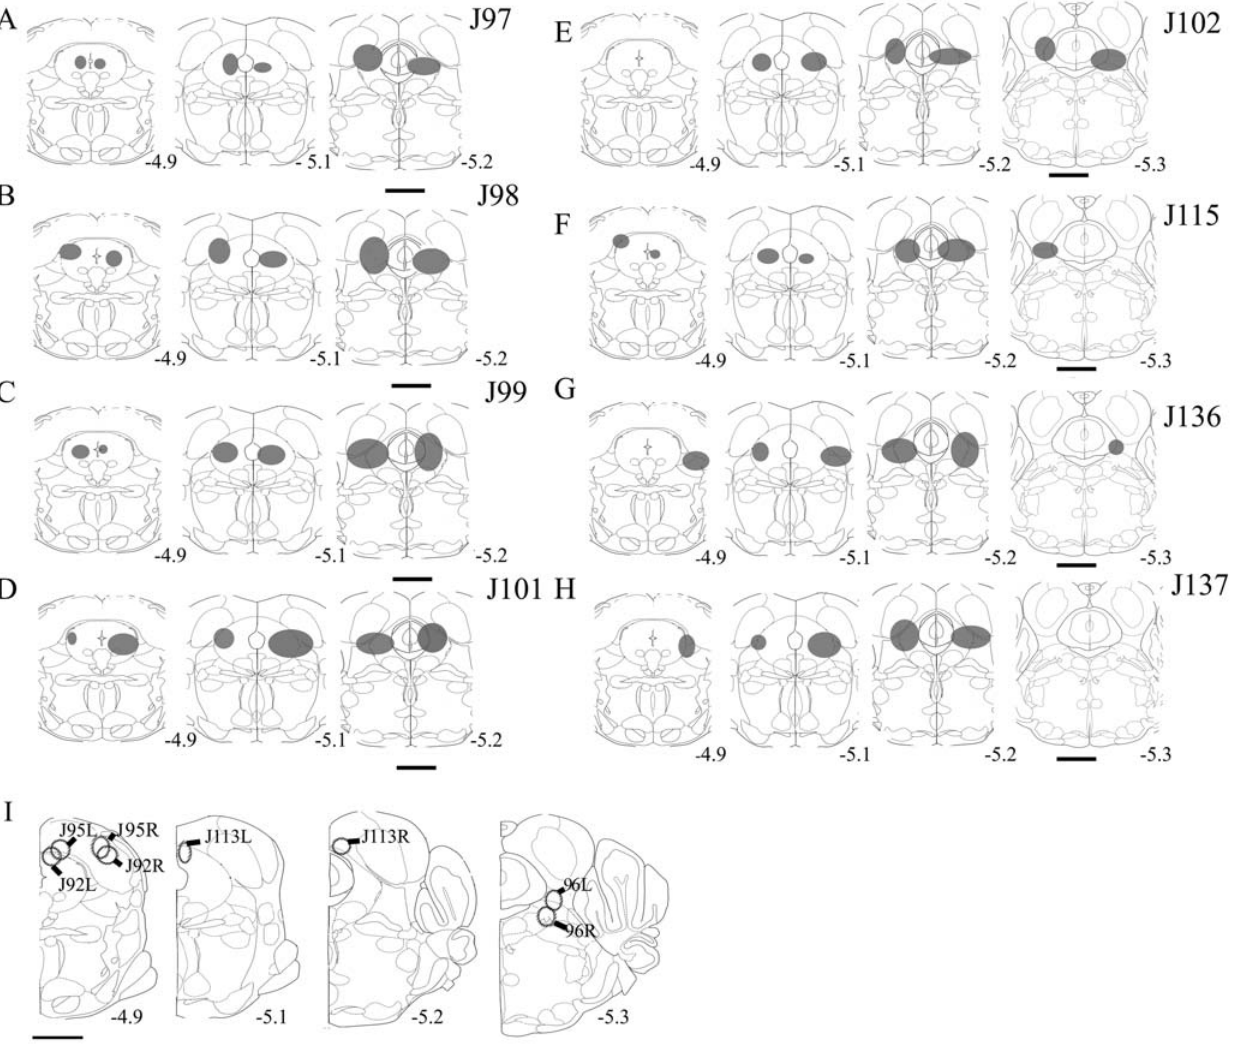
Figure 8. Schematic representation of the extent of lesions as defined by the absence of NeuN staining and the loss of GFP neurons in the vl PAG area of the pons in the FVB-GFP mice. The lesion extent shown in the pontine sections of the mice in A-H, significantly increased REM sleep during the dark phase, but the lesions in some mice (n=4, the tip of the injections shown in I) did not cause significant changes in night time REM sleep compared to the saline injected control mice. Scale 2 1.0